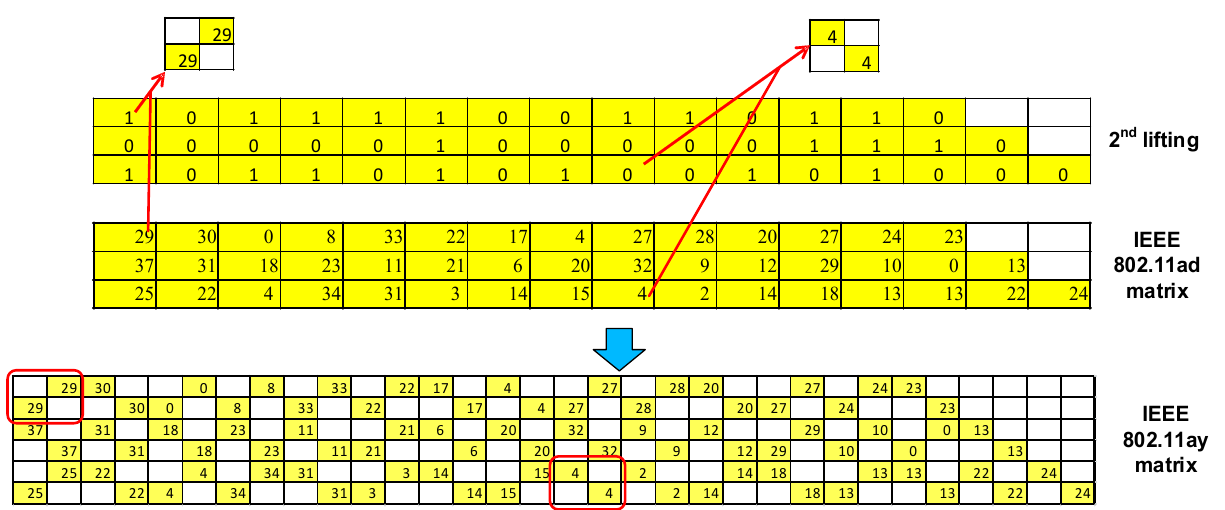
Figure 8. Generation of parity check matrix at IEEE 802.11ay R = 13/16.